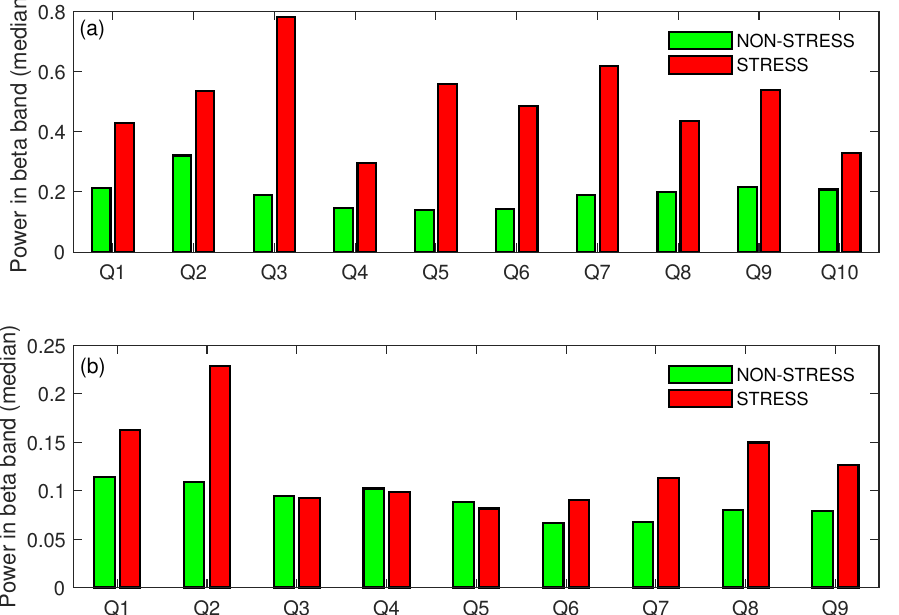
Figure 5. STRESS vs. NON-STRESS condition—difference in medians across events in Task A ( a ), and Task B ( b ); Q: Question.